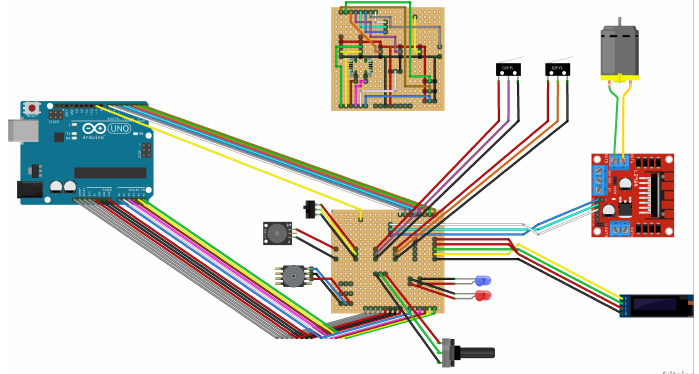
Figure 18. Schematic of the electrical connections for eARM system. The design will require